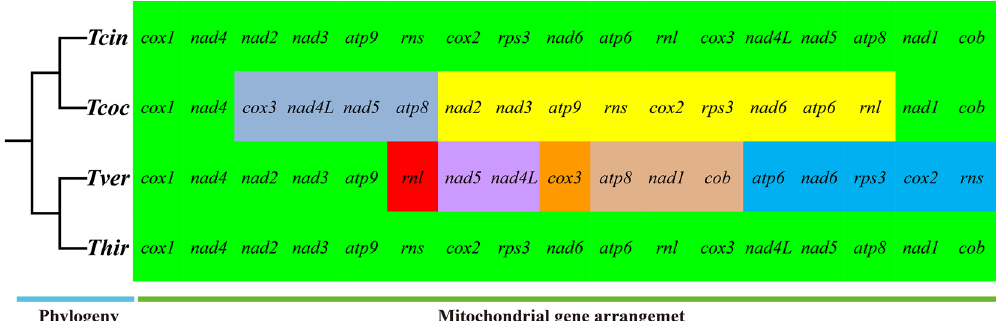
Figure 2. Gene order comparation between 4 Trametes species. All genes are shown in order of occurrence in the mitochondrial genome, starting from cox1 . Fifteen core protein coding genes and two rRNA genes were included in the gene arrangement analysis. Genes with a green background indicate that they are conservative in Boletales species. Genes with other colored background indicate that they have gene rearrangements. The phylogenetic positions of 4 Trametes species were established using the Bayesian inference (BI) method and Maximum Likelihood (ML) method based on concatenated mitochondrial genes. Species and NCBI accession number used for gene arrangement analysis in the present study are listed in Supplementary Table